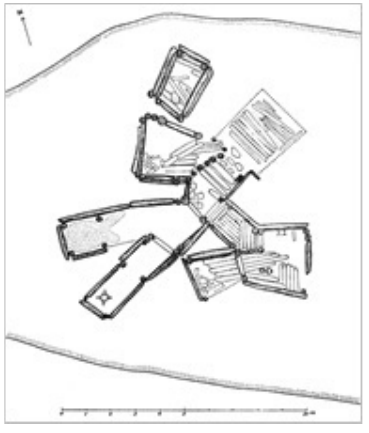
Figure 7: Qimiarzuq (Jabbertown), House 2 (from Larsen and Rainey 1948: 171).